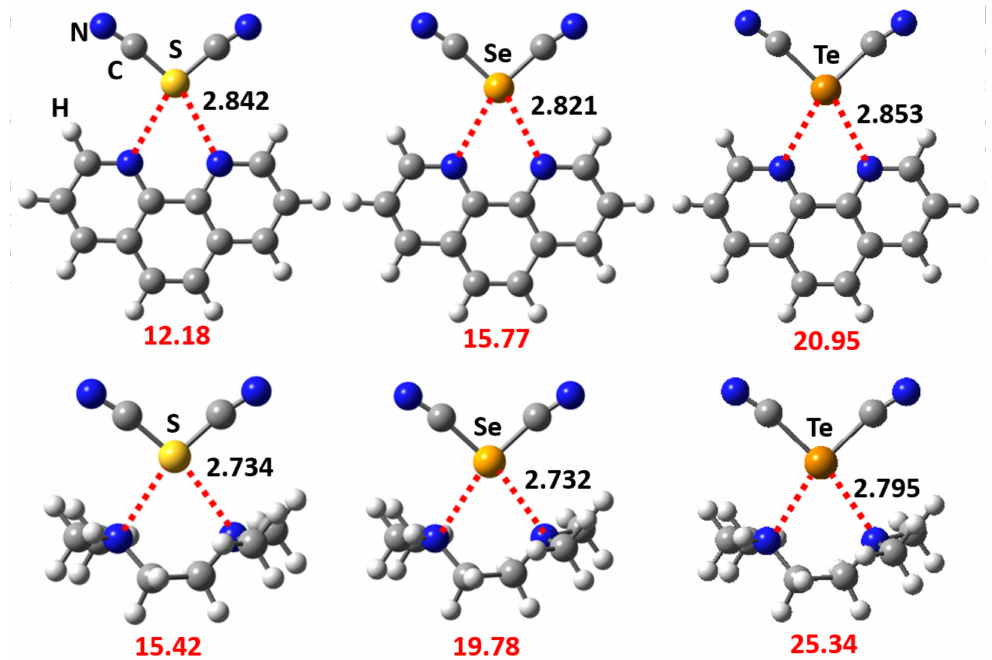
Figure 3. B3LYP-D3/def2-TZVPP binding energies (red numbers, in kcal/mol) of the complexes